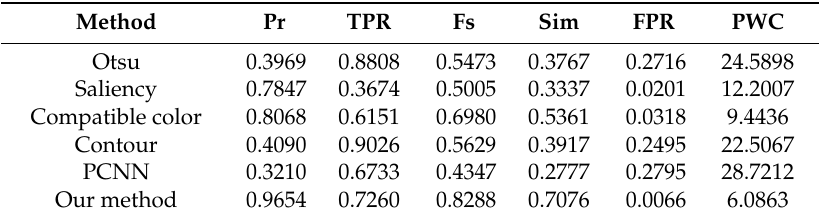
Table 1. Average performance comparison of Otsu, saliency, compatible color, contour, PCNN, and our method. Precision (Pr); true positive rate (TPR); F-score (FS); similarity (Sim); false positive rate (FPR); percentage of wrong classifications (PWC).